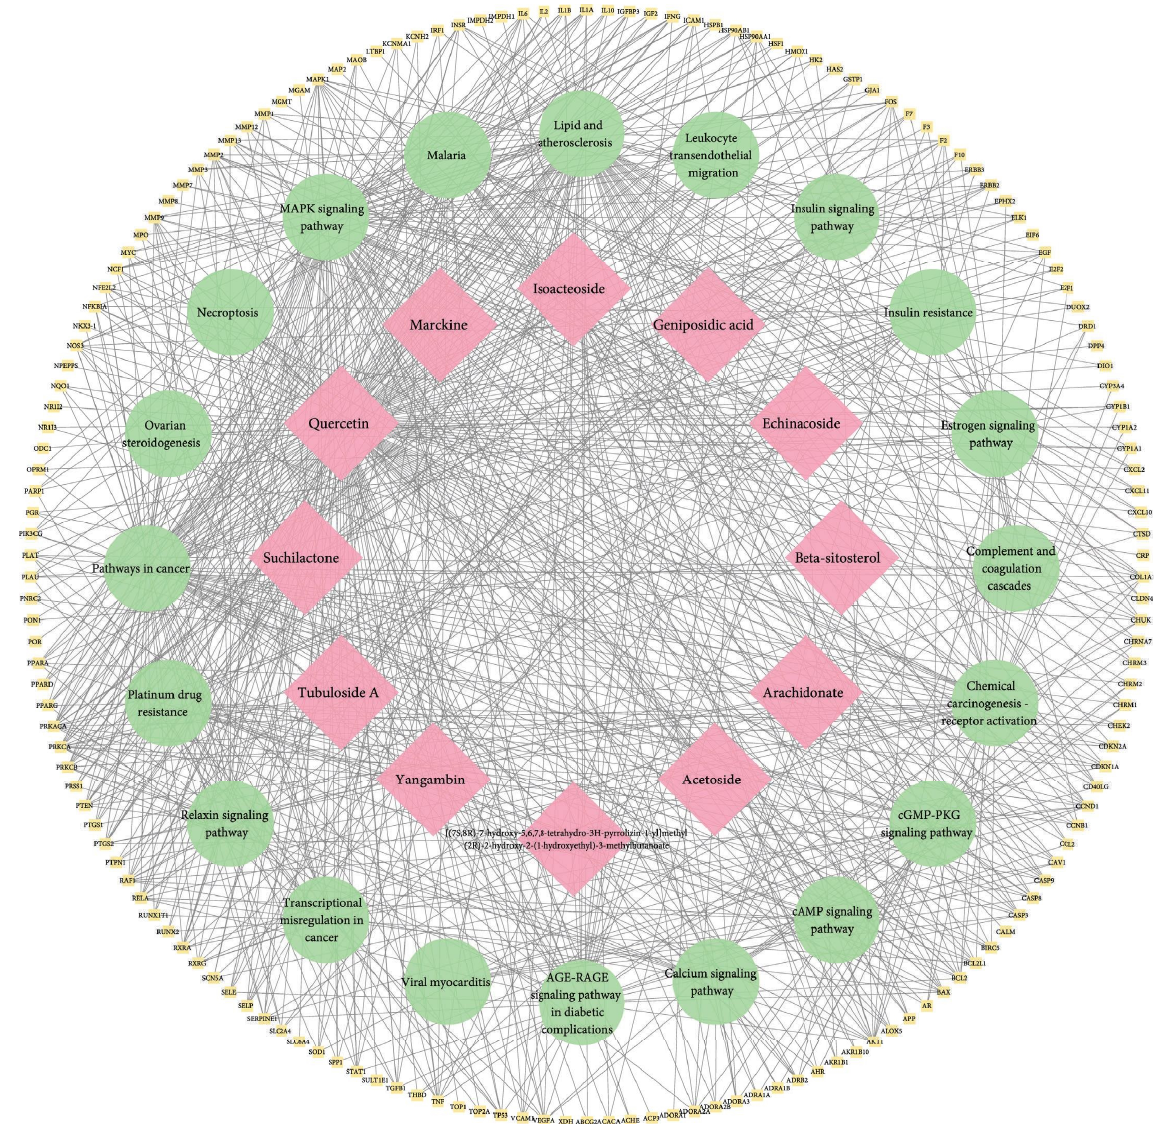
Figure 13: C-T-P